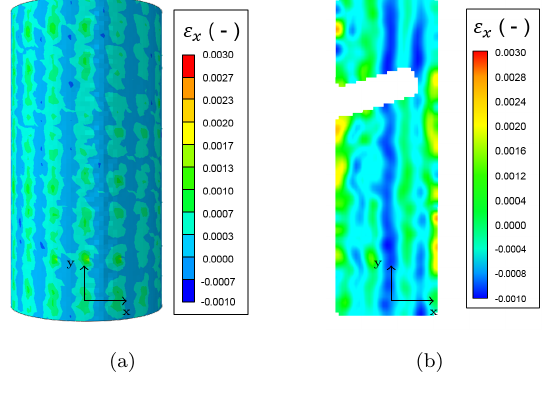
Figure 6. Strain distribution in the simulated struc- ture (a) and experimentally obtained strain distribu- tion (b) at a rotation angle of 0.25 ◦ , with ε x being the strain in circumferential direction of the cylinder.